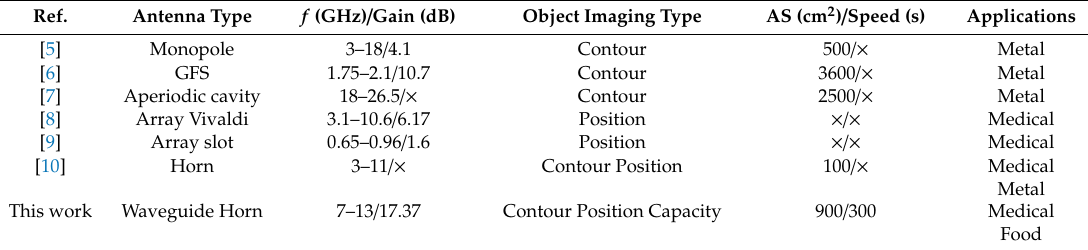
Figure 10. The health sensing of ( a ) a fresh egg, ( b ) a fresh egg after extracting 6 mL thick albumen, ( c ) a fresh egg after extracting 12 mL thick albumen, and ( d ) a fresh egg after extracting 18 mL thick albumen by using the waveguide antenna microwave imaging sensing system (all of the microwave images were scanned at 10.4 GHz). Table 2. Comparison of other previous works (AS is the area size of scanning, GFS is the ground-folded slot).